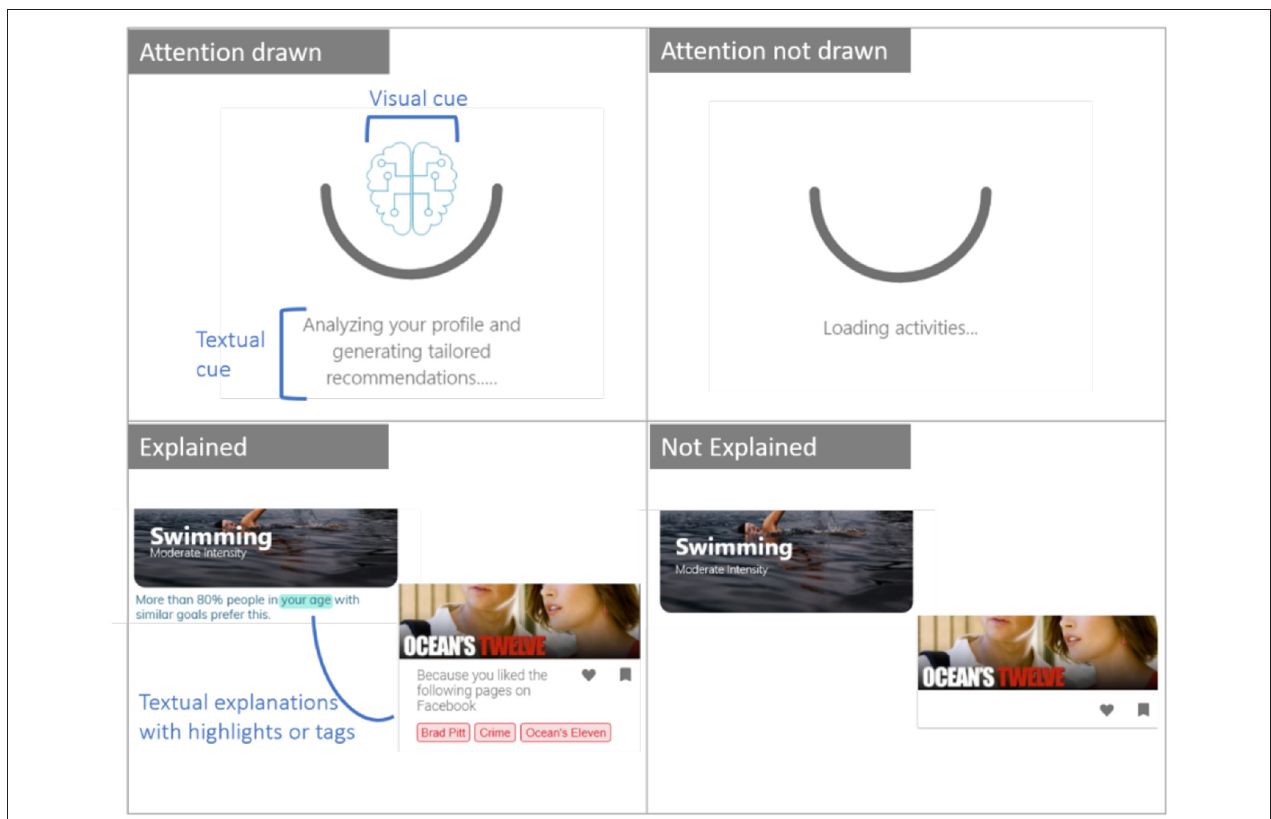
FIGURE 1 | Overview of designs showing the manipulations that were used for the